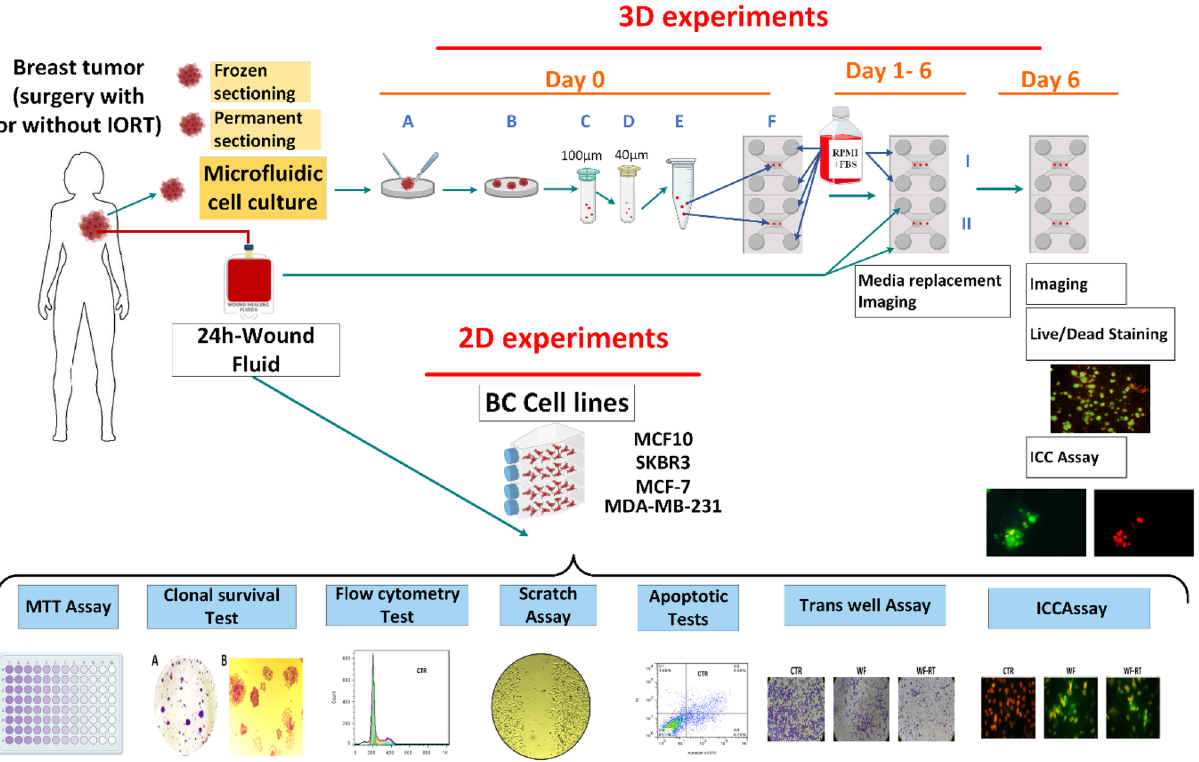
Figure 1. The graphical abstract of the study. Patients were classified into two groups: the Control group (only surgery) and the Test group (surgery + IORT). 3D experiments: On day 0, ( A , B ) Mechanically and enzymatically dissociation of the tumor specimens, respectively. ( C , D ) Filtration of the dissociated specimens using 100 µm and 40 µm cell strainers, respectively. ( E ) Embedding the spheroids into prepared collagen gel solution. ( F ) Filling the gel (collagen + spheroids) into the central channels and RPMI + FBS into media channels of the microfluidic devices. On days 1–6, I: Control device whose side channels are loading up with RPMI + FBS. II: Test device whose media channels are loading up with 24 h-wound fluid (WF/WF-RT). Optical imaging and media replacement were accomplished from day 0 to day 6 (RPMI + FBS for control devices and 24 h-wound fluid for test devices). On day 6, Live/Dead staining, immunocytochemistry, and fluorescent imaging. 2D experiments: assays on breast cancer cell lines under 24 h-WF/WF-RT treatment. The figure was created using Biorender (https:// biore nder.